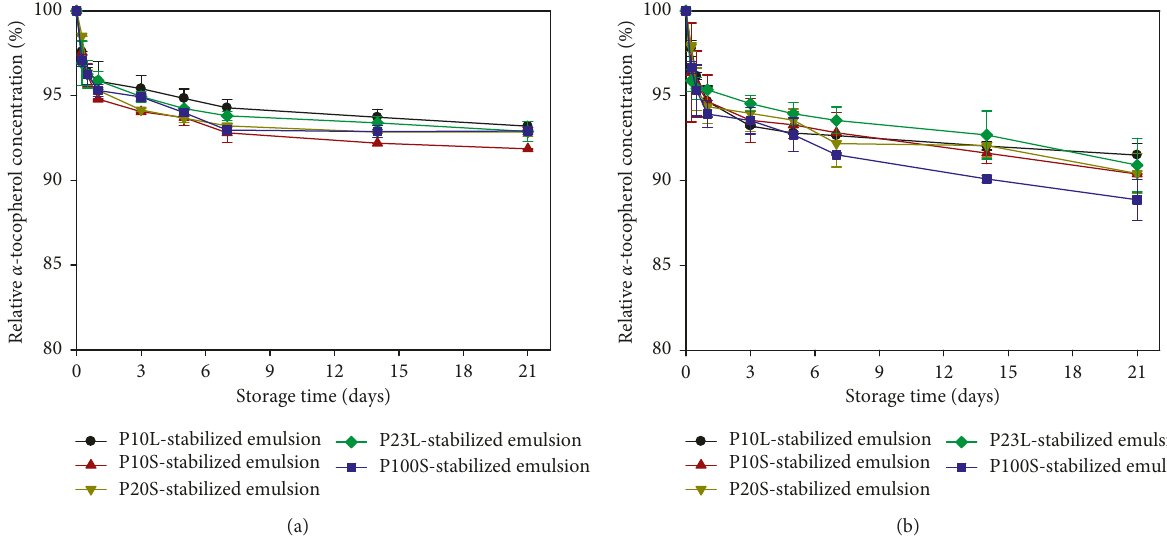
Figure 4: Change in concentration of α -tocopherol in emulsions in the presence of ferric iron at pH 7 (a) and 3 (b) stored at 25 ° C. P10L, polyoxyethylene 10 lauryl ether; P10S, polyoxyethylene 10 stearyl ether; P20S, polyoxyethylene 20 stearyl ether; P23L, polyoxyethylene 23 lauryl ether; P100S, polyoxyethylene 100 stearyl